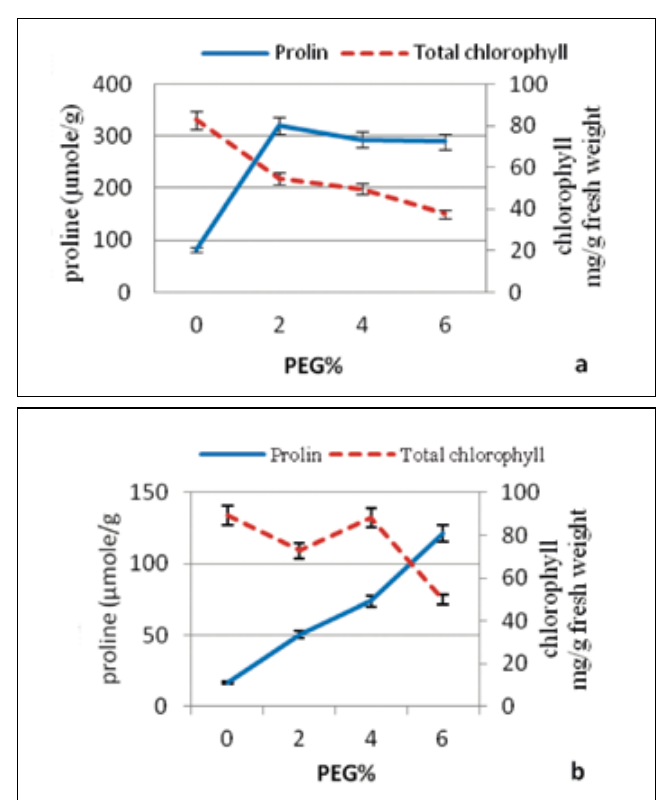
Fig. 2 - Changes in proline and total chlorophyll in two fig cultivars: Sabz (a) and Siah